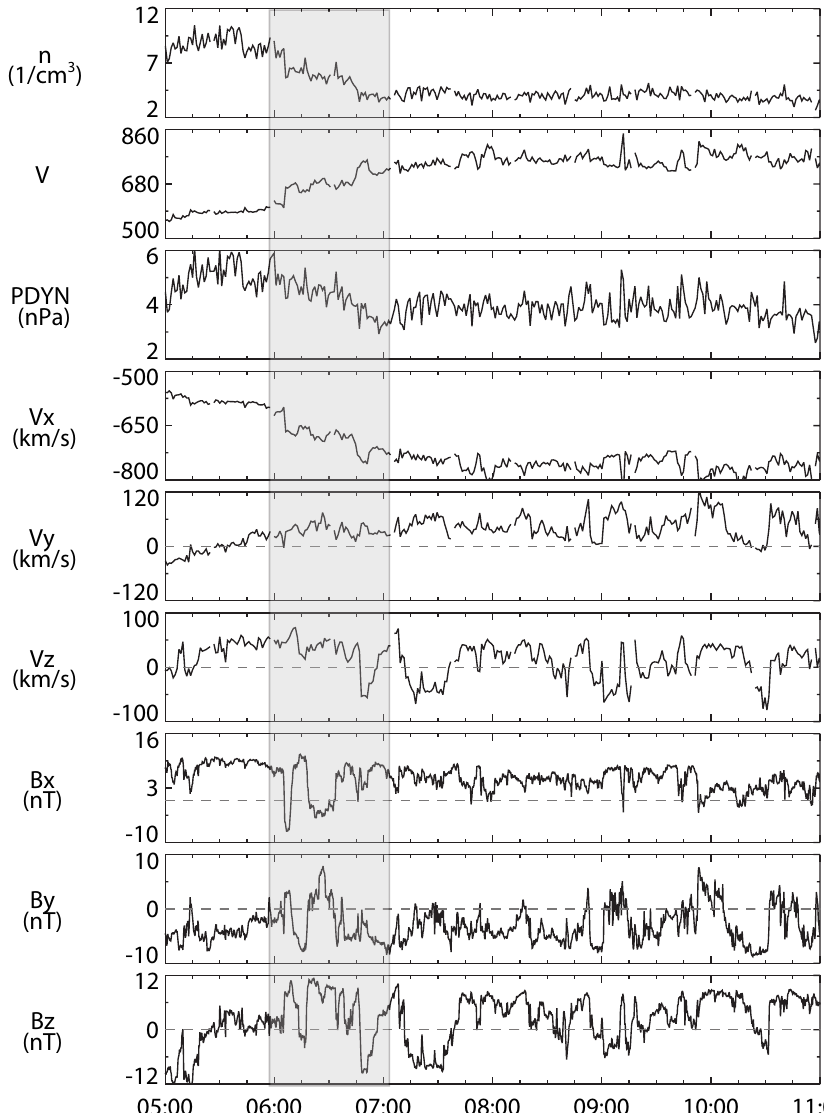
Fig. 1. Solar wind and IMF conditions measured by ACE spacecraft (it has been time-shifted by 38min) during the interval 05:00–11:00 UT. From top to bottom are: density in cm − 3 , solar wind speed in km/s, solar wind dynamic pressure in nPa, three components of solar wind velocity in km/s, and three components of the IMF in nT. The highlighted region in Fig. 1 indicates the interval during which the ULF pulsations were seen. GSM coordinates are used